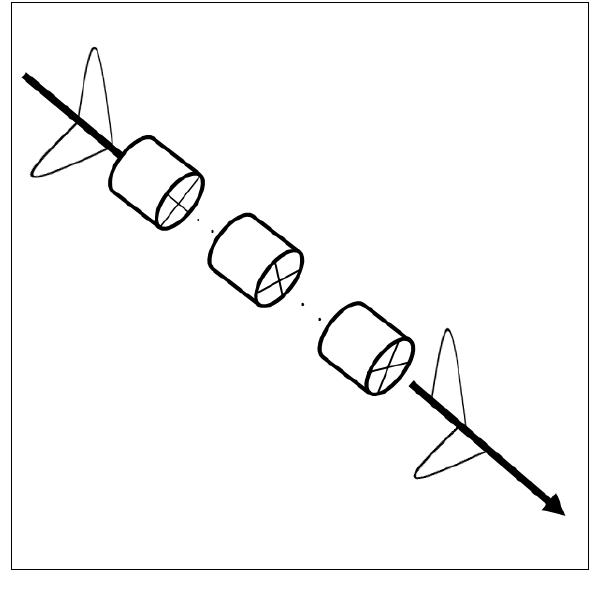
Diagram depicting how a state of polarisation is rotated as it is transmitted through a fibre optic cable. The cross sections of the fibre show that the orthogonal components of the state of polarisation are rotated during transmission as a result of their differing speeds. For illustrative purposes, this figure demonstrates a linear rotation, but practically, the fibre can introduce an elliptical element into the state of polarisation as